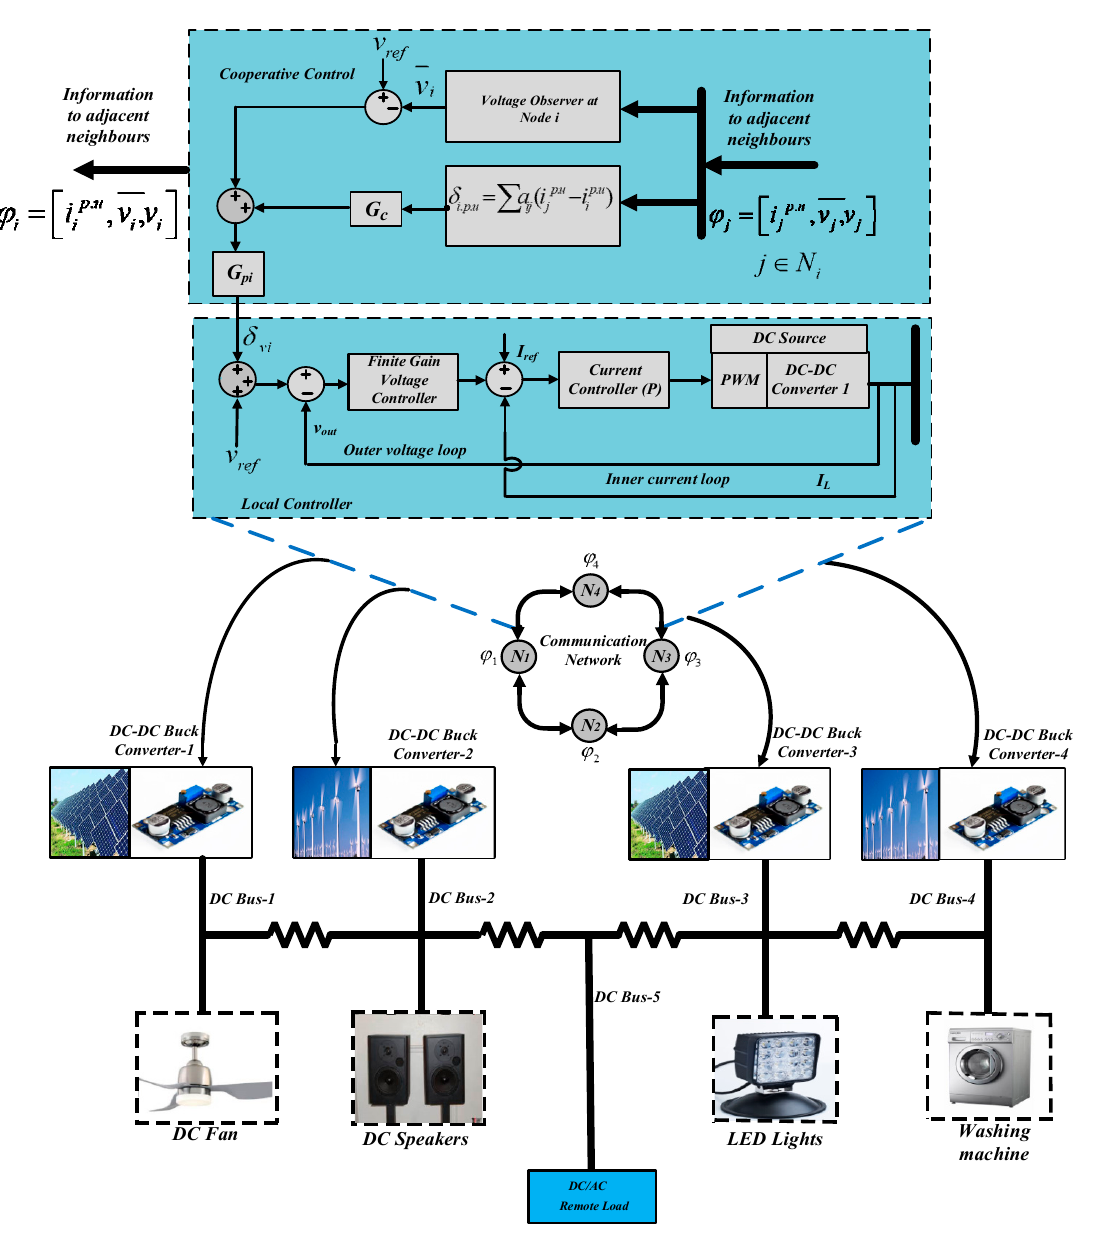
Figure 3. Proposed local controller with cooperative control